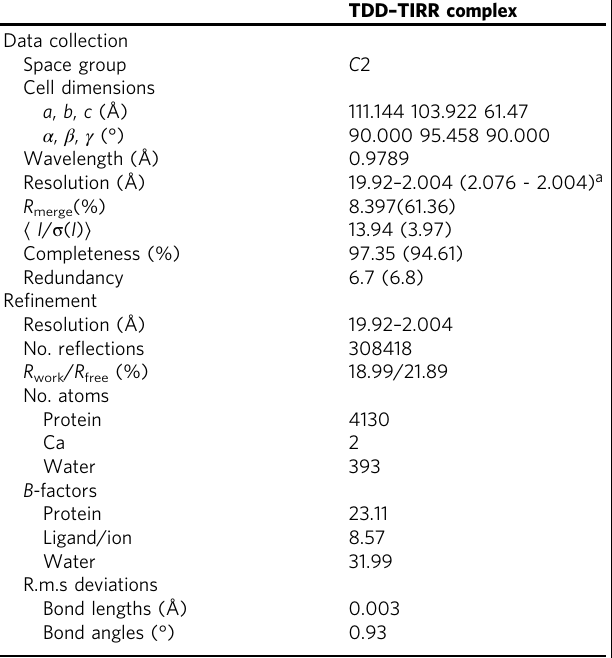
Table 1 Data collection and re fi nement statistics of